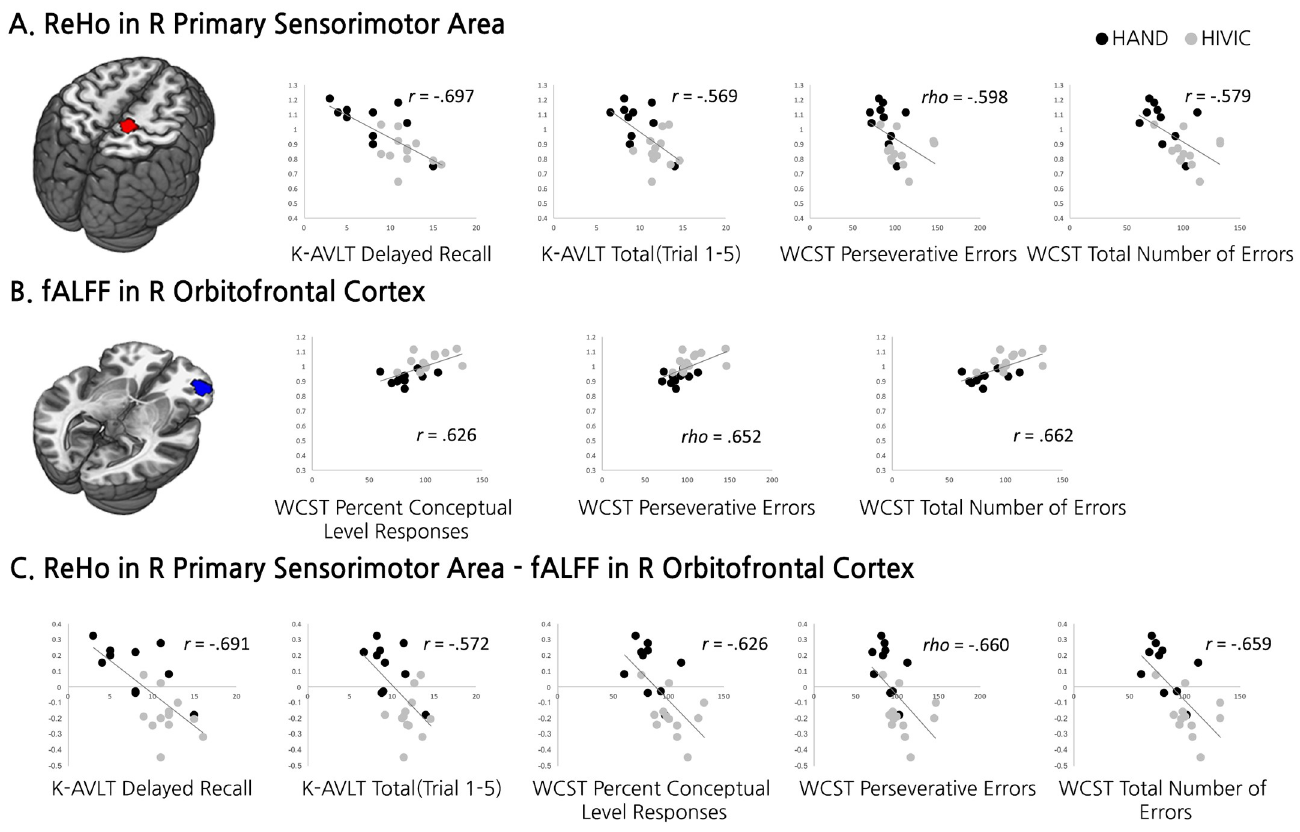
Fig 4. The results of correlation analysis between mean standardized rsfMRI values and NP test scores. (A) The left panel shows the ROI of the primary sensorimotor area which showed significant difference in ReHo values between HAND and HIV-IC. Scatter plots depicted in the right panel show significant correlations between mean ReHo values in the ROI and NP test scores. (B) The left panel shows the ROI of the orbitofrontal cortex which showed significant difference in fALFF values between HAND and HIV-IC. Scatter plots depicted in the right panel show significant correlations between mean fALFF values in the ROI and NP test scores. (C) Scatter plots show significant correlations between NP test scores and the rsfMRI values where standardized fALFF values in the orbitofrontal cortex are subtracted from standardized ReHo values in the primary sensorimotor